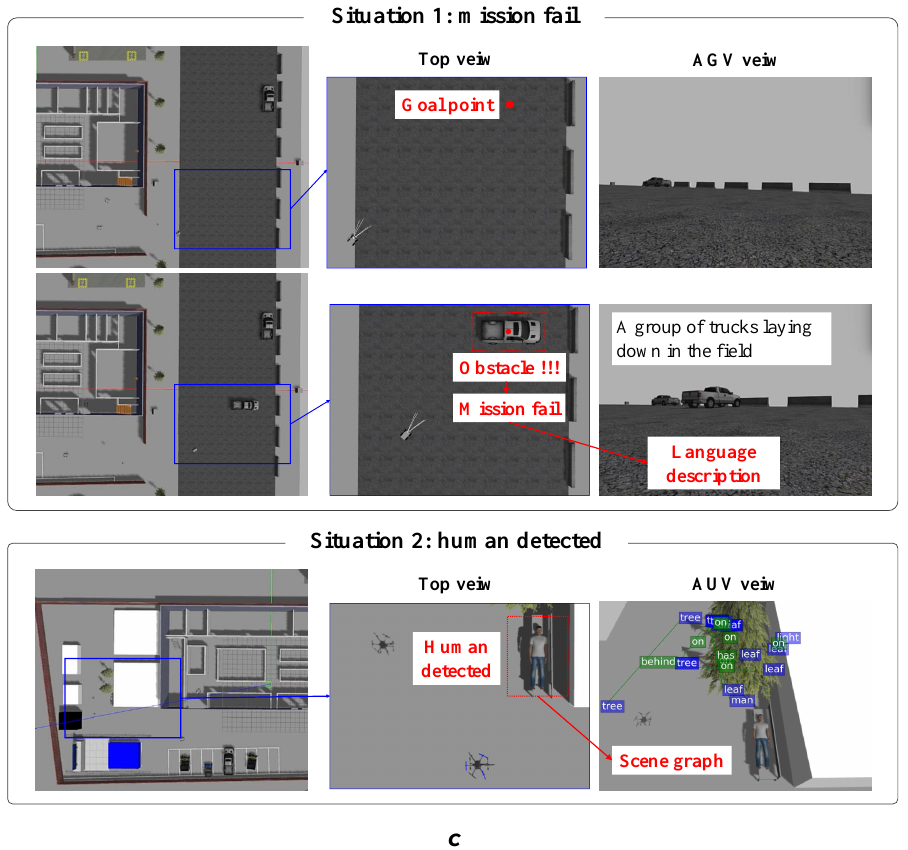
Figure 8. Experiment results: ( a ) Examples of generated language descriptions; ( b ) Examples of the generated scene graphs; ( c ) Results of the